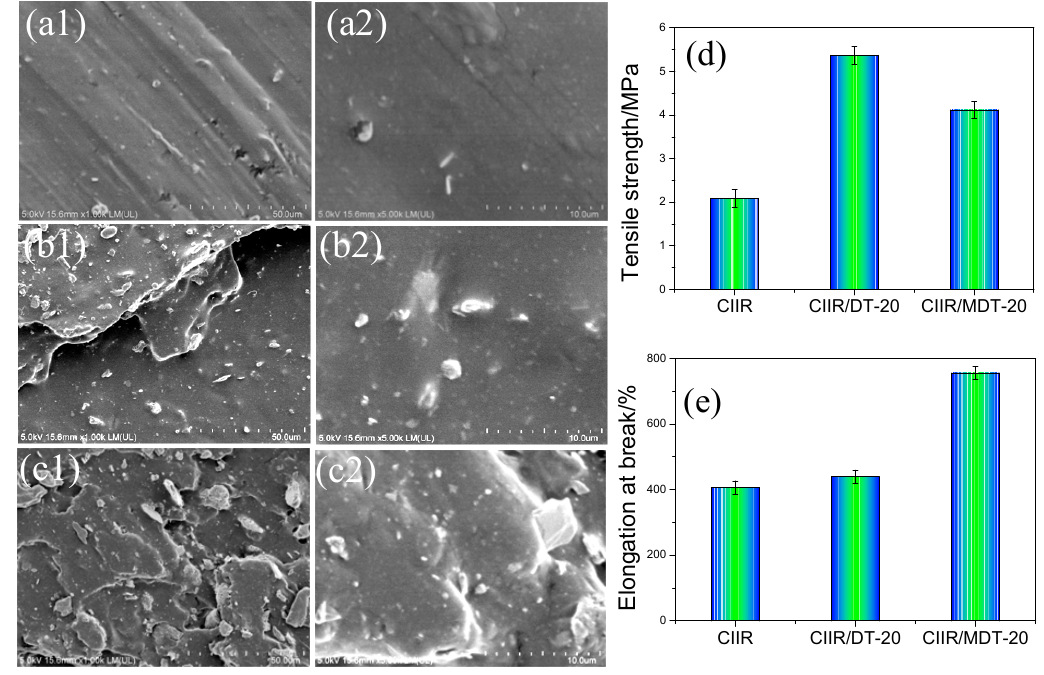
Figure 7. SEM of different CIIR systems: ( a1 , 2 ) pure CIIR; ( b1 , 2 ) CIIR/DT-20; and ( c1 , 2 ) CIIR/MDT-20; ( d ) tensile strength; and ( e ) elongation at break.